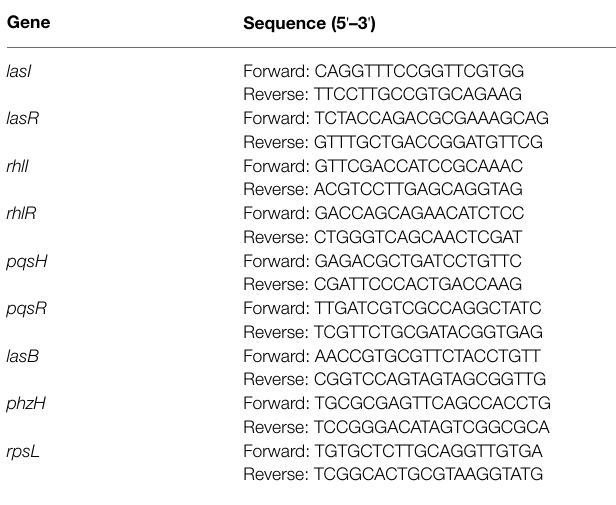
TABLE 1 | Primers used in this